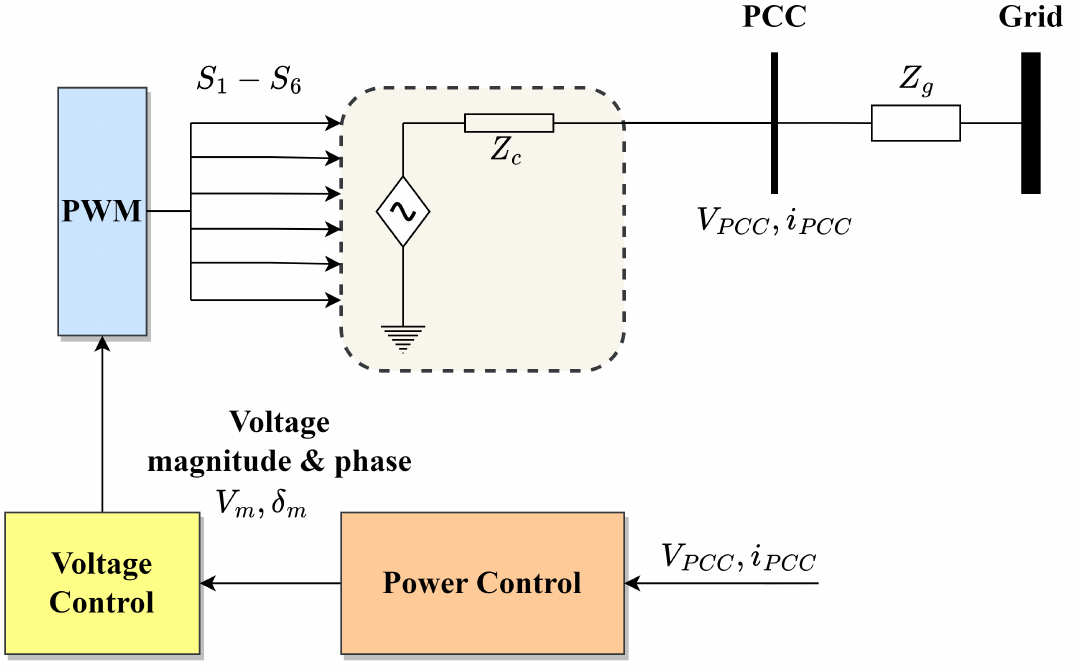
Figure 3. Control approximations of GFM